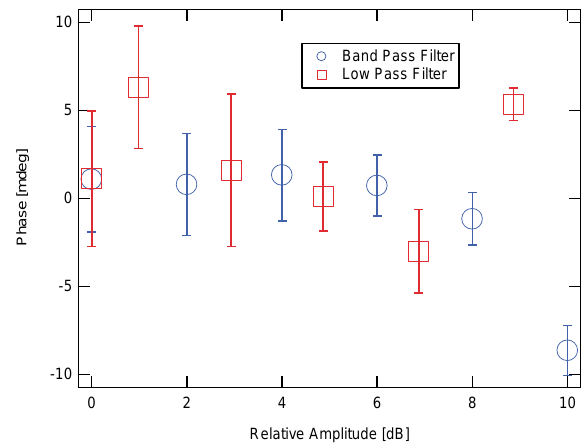
FIG. 4. (Color) Variation in the relative phase between two chan- nels in the test setup as a function of generator output power. The circles correspond to an analog filter setup identical with the one used for later measurements with beam. The squares are results obtained with a low-pass 700 MHz analog filter for the simulated beam